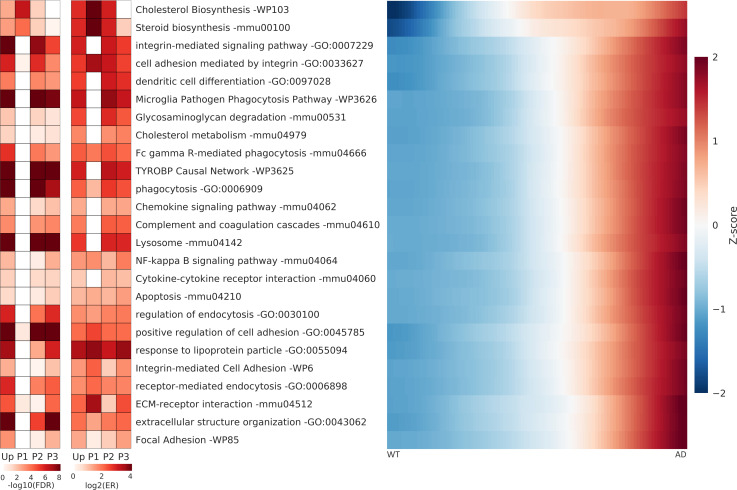
The false discovery rate and enrichment ratio value for upregulated pathways.The false discovery rate (FDR) and enrichment ratio (ER) values for the selected pathways, which were estimated by the gene list of each subset (Up, P1, P2, P3). Each pathway's heatmap was estimated by averaging the transition curves of the genes belonging to the Up list. Some pathways exist in which the ER values are very large but whose FDR values are not significant. This is the reason why the number of genes in subset lists such as P1 and the annotated genes in some pathways (such as cell adhesion mediated by integrin) are small; consequently a few overlapping genes seem to enhance the ER values. Conversely, the pathways with many annotated genes tend to have very small FDR values even at low enrichment ratios, such as phagocytosis. Hence, we present both the FDR and ER simultaneously.